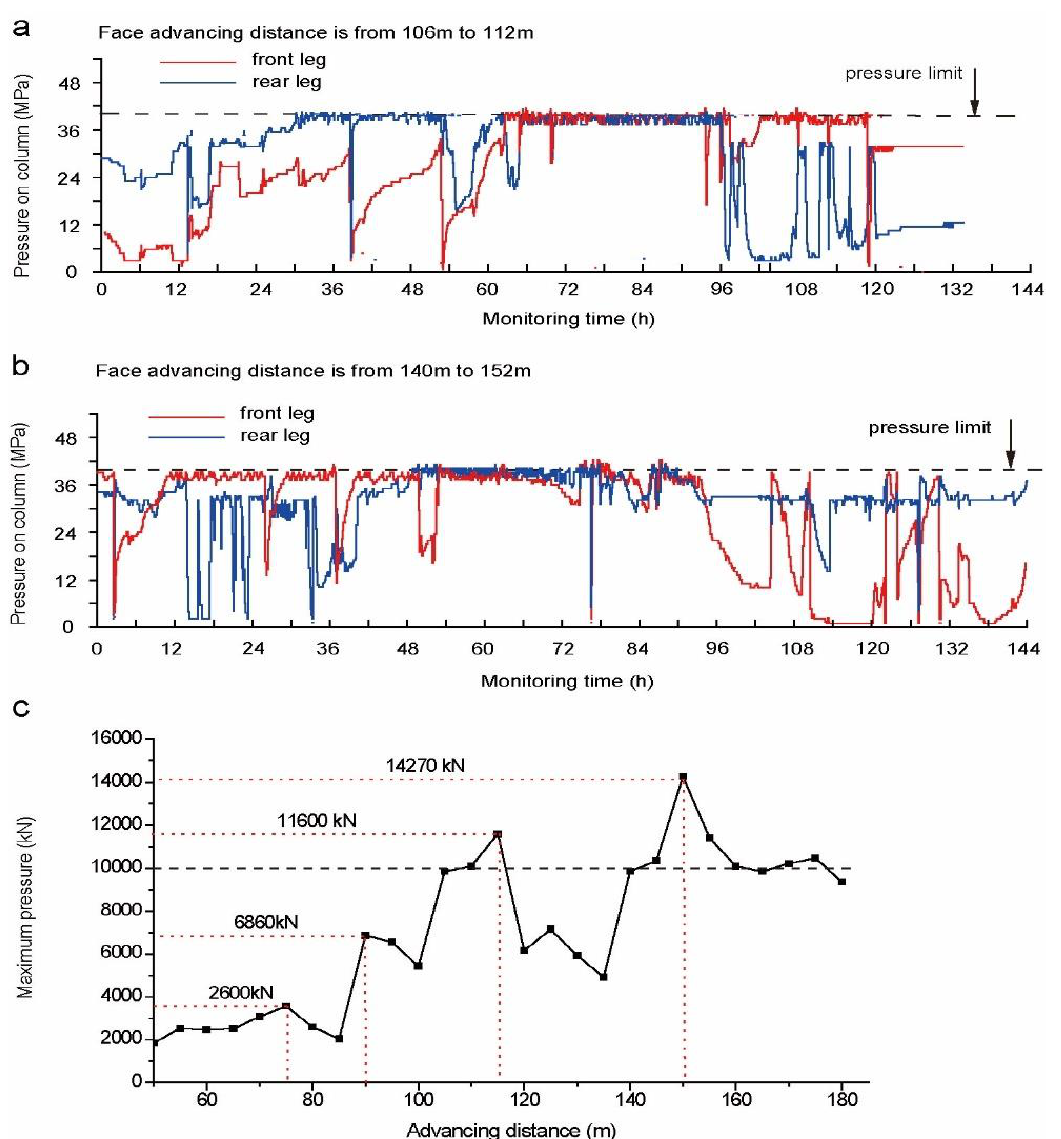
Figure 13. Typical mining pressure on the columns and maximum load on support. (( a ). Mining pressure on column when face advancing from 106 m to 112 m; ( b ). Mining pressure on column when face advancing from 140 m to 152 m; ( c ). Practical maximum pressure on the support in mining process).